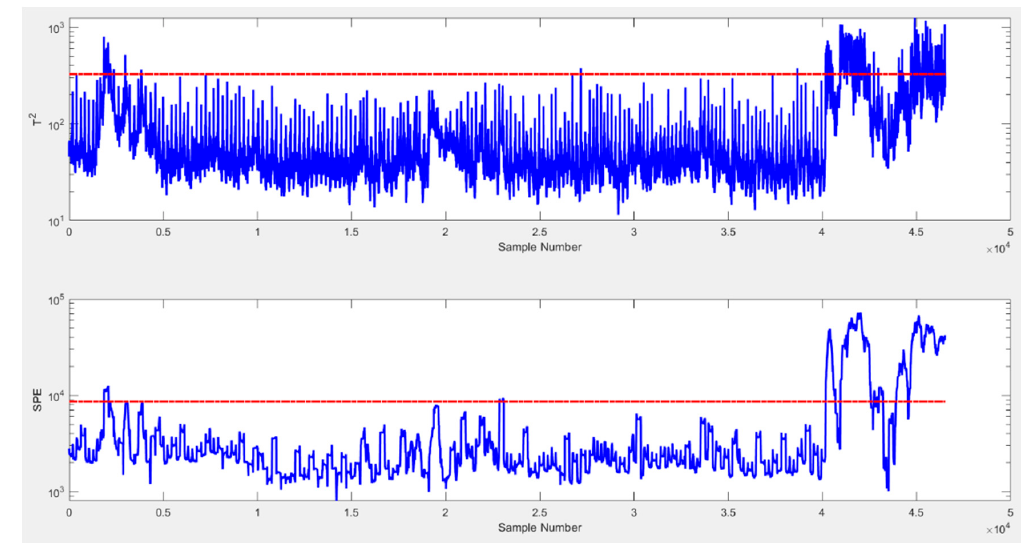
Figure 3. Canonical variate analysis (CVA) applied to the complete dataset.